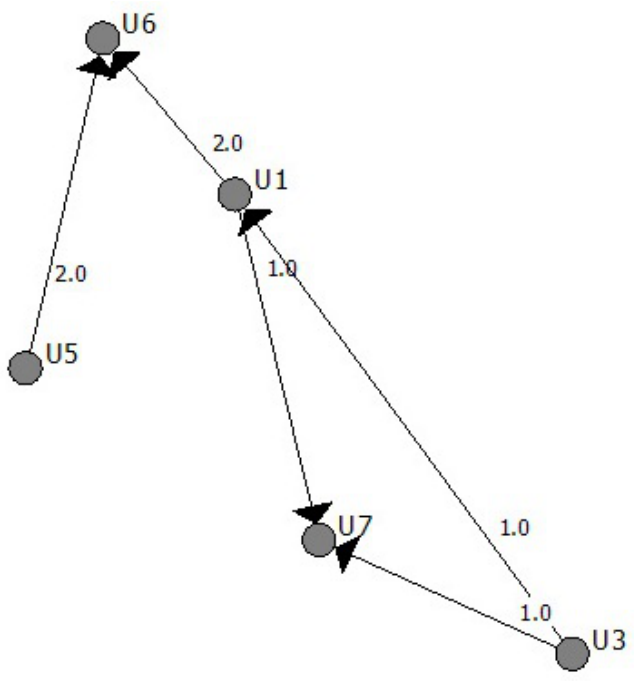
Figure 2. Graphical representation of one